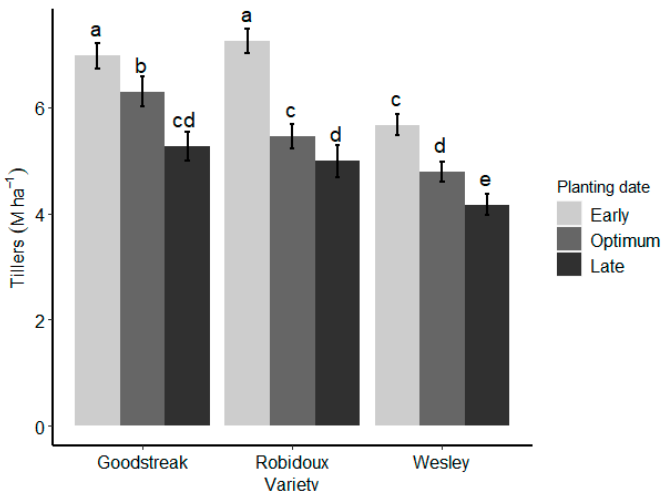
Figure 10. Effect of planting × variety interaction on the number of tillers expressed in million ha − 1 at Sidney. The error bars represent the of the mean. Different letters on top of column bars indicate a significant mean difference at p < 0.05.